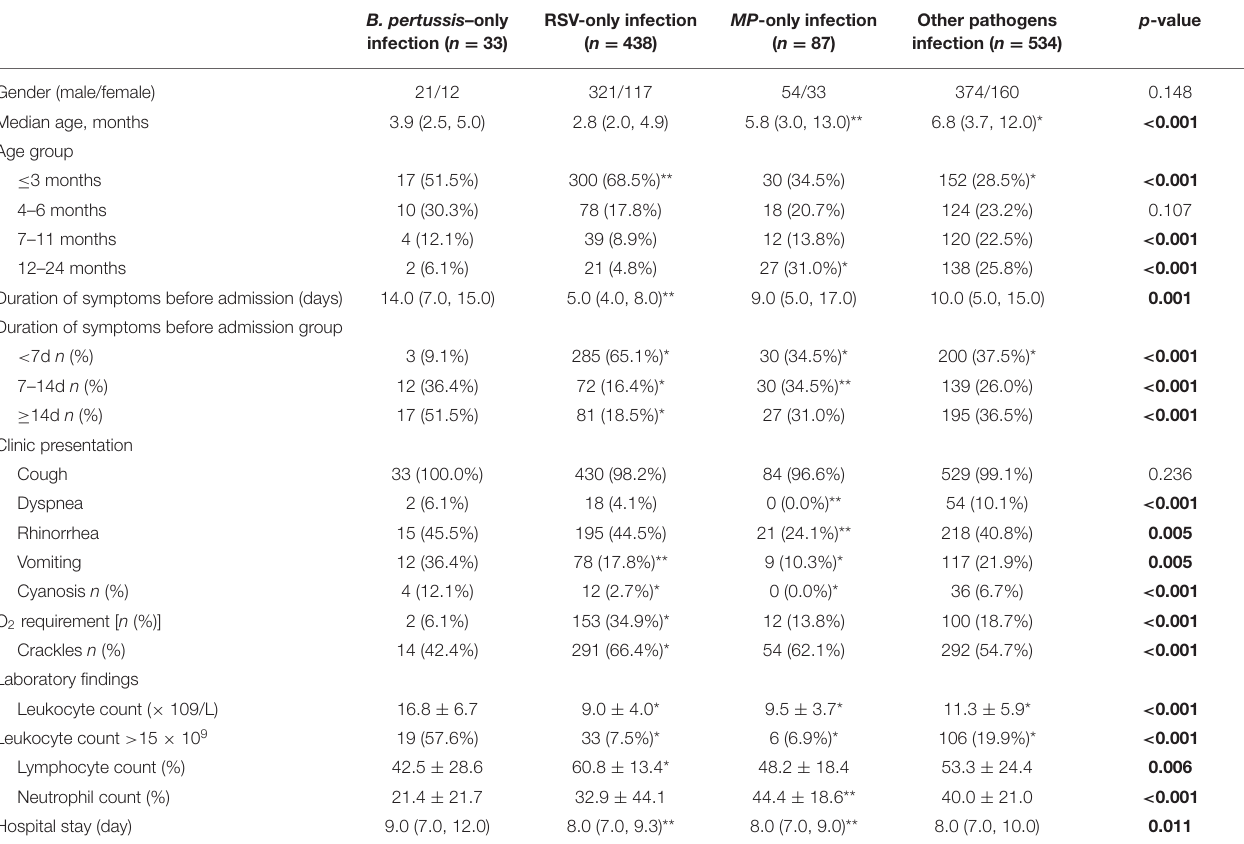
TABLE 2 | Select characteristics of hospitalized children with B. pertussis- only infection compared with RSV - only, MP - only, and other pathogens infection ( n = 1,092). B. pertussis –only infection ( n =